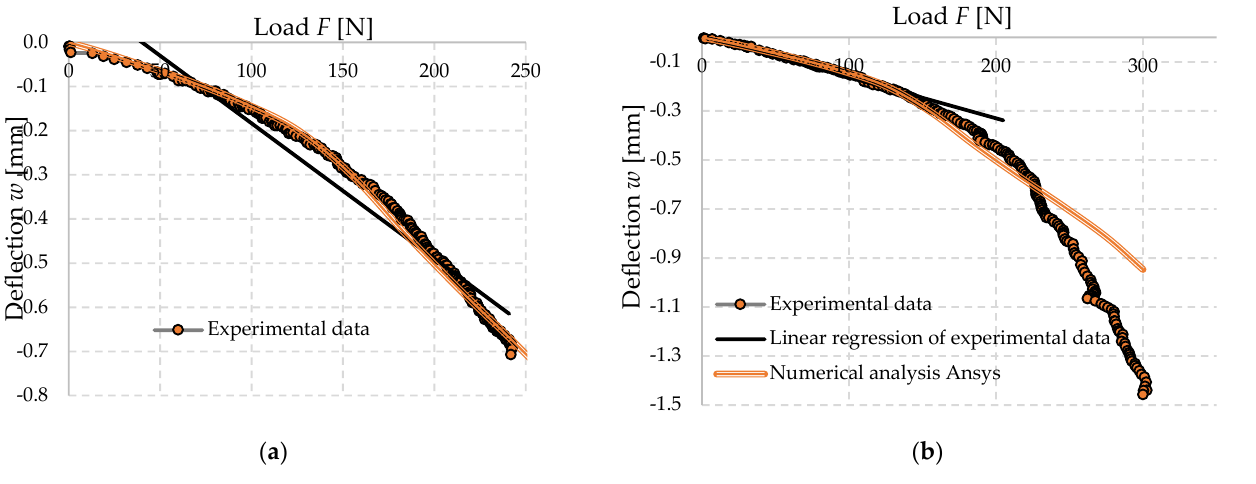
Figure 23. Comparison of numerical dependence of deflection (cantilever end) on force (load of the cantilever end) – investigated material FC500 ( a ) specimen 34030420 medium load capacity; ( b ) spec- imen 32030420 highest load capacity.